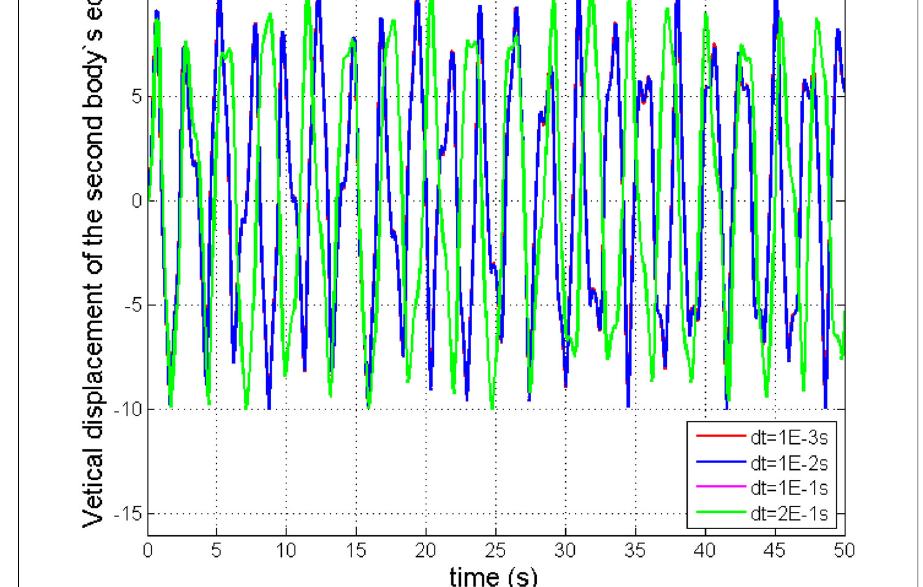
Fig. 7 Displacements for different (cid:15) t